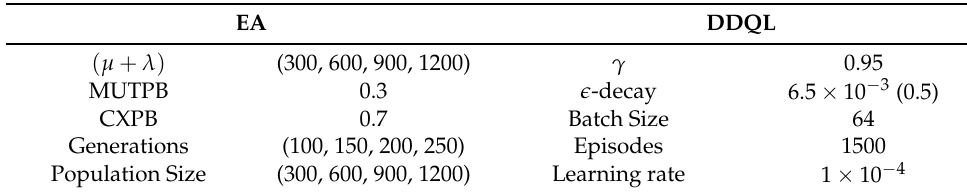
Table 5. Parameters for both approaches.